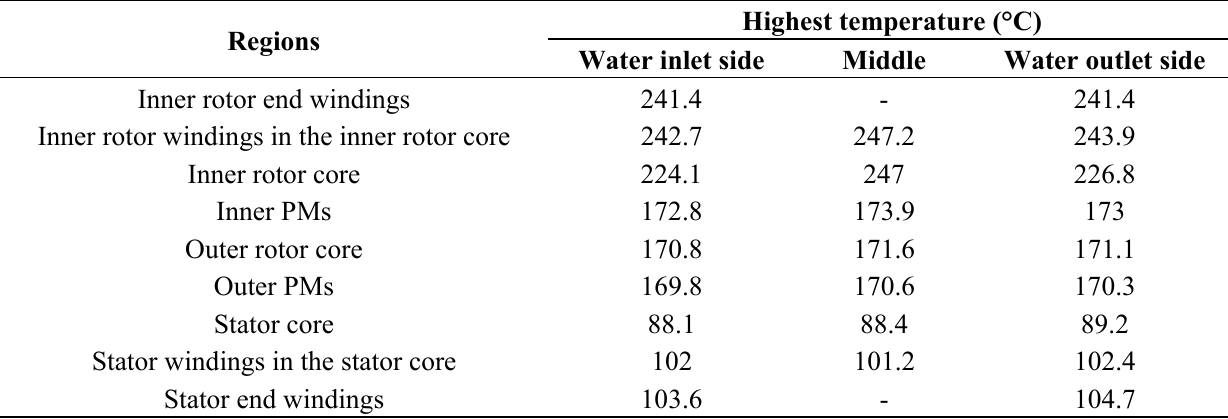
Table 6. Highest temperatures of different parts in the